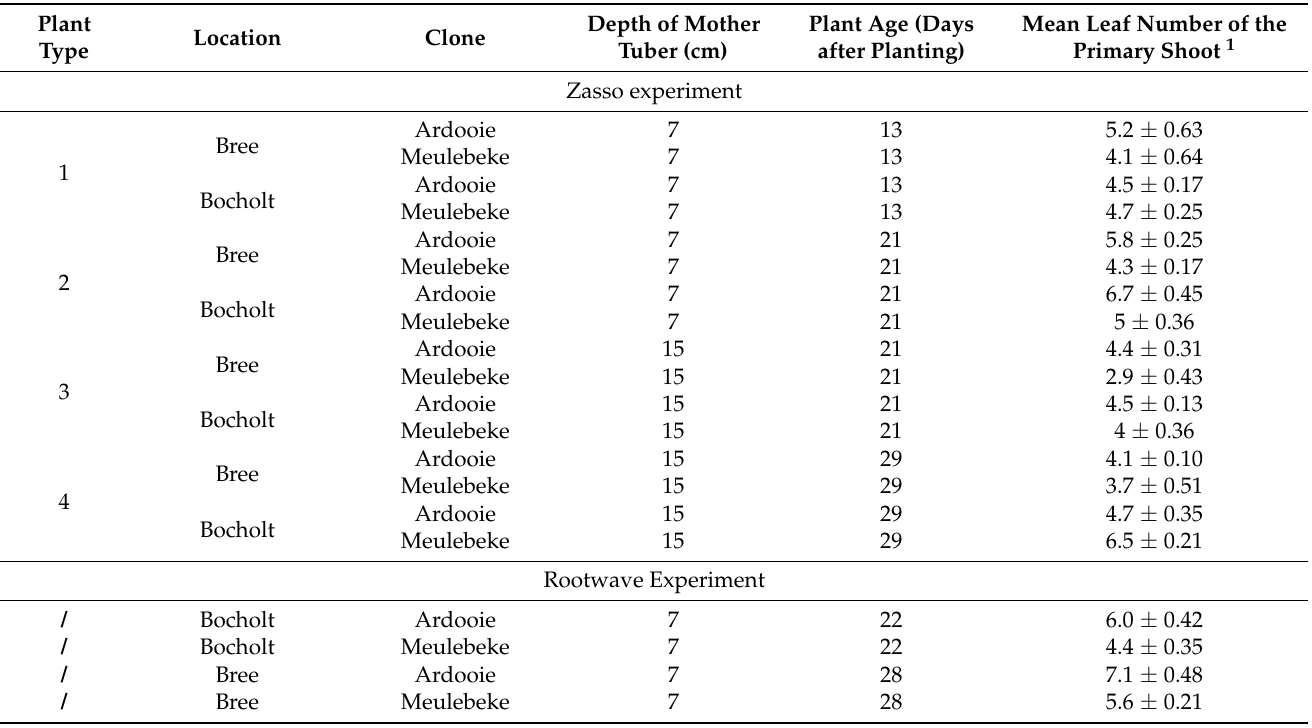
Table 3. Characteristics of the plants on the day of electrocution with the Zasso or the Rootwave electric weeding